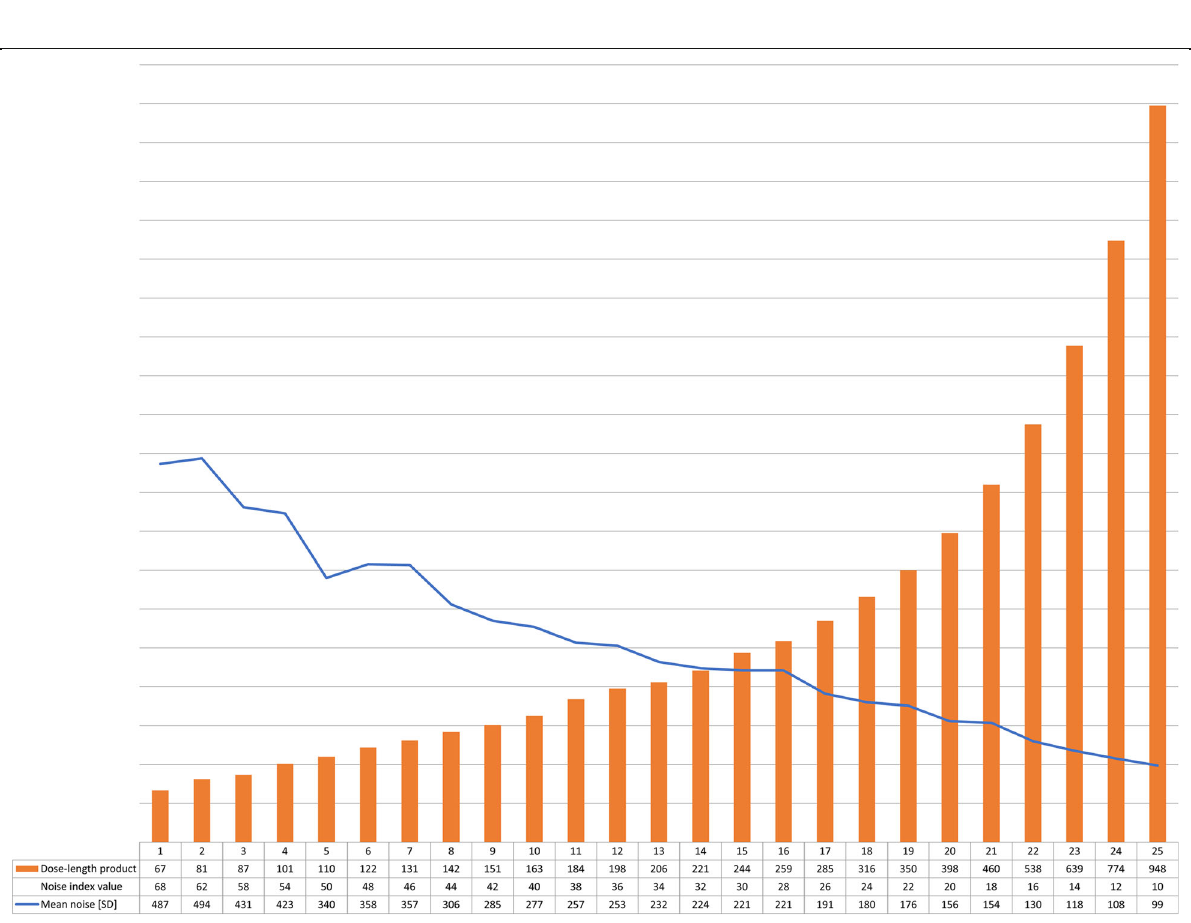
Fig. 3 Comparison of 25 SURE Exposure3D noise settings and noise standard deviation values at vertebral Th11 – 12 level (at 1.0-mm thickness) in the anthropomorphic phantom РН -1 Multipurpose Chest Phantom N1 (body mass index 29). Dose-length product values are in orange. The average standard deviation values are in